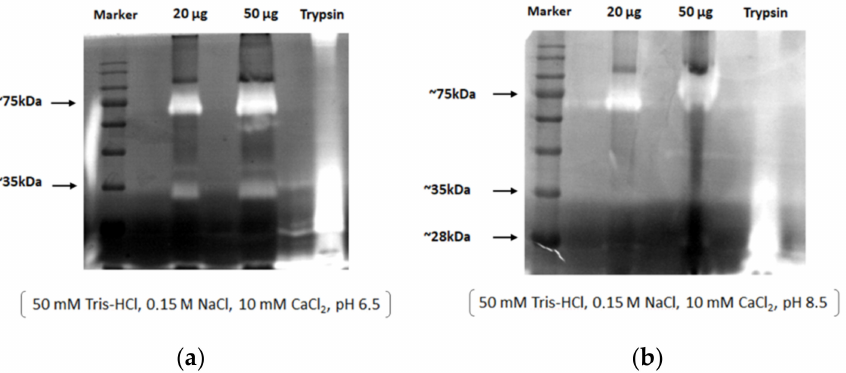
Figure 2. Zymographs of A. platensis lysate (20 µ g and 50 µ g) with casein as a substrate, after 16 h of incubation in 50 mM Tris-HCl, 0.15 M NaCl, 10 mM CaCl 2 with ( a ) pH 6.5 and ( b ) pH 8.5. Trypsin was used as a control (0.5 Units).